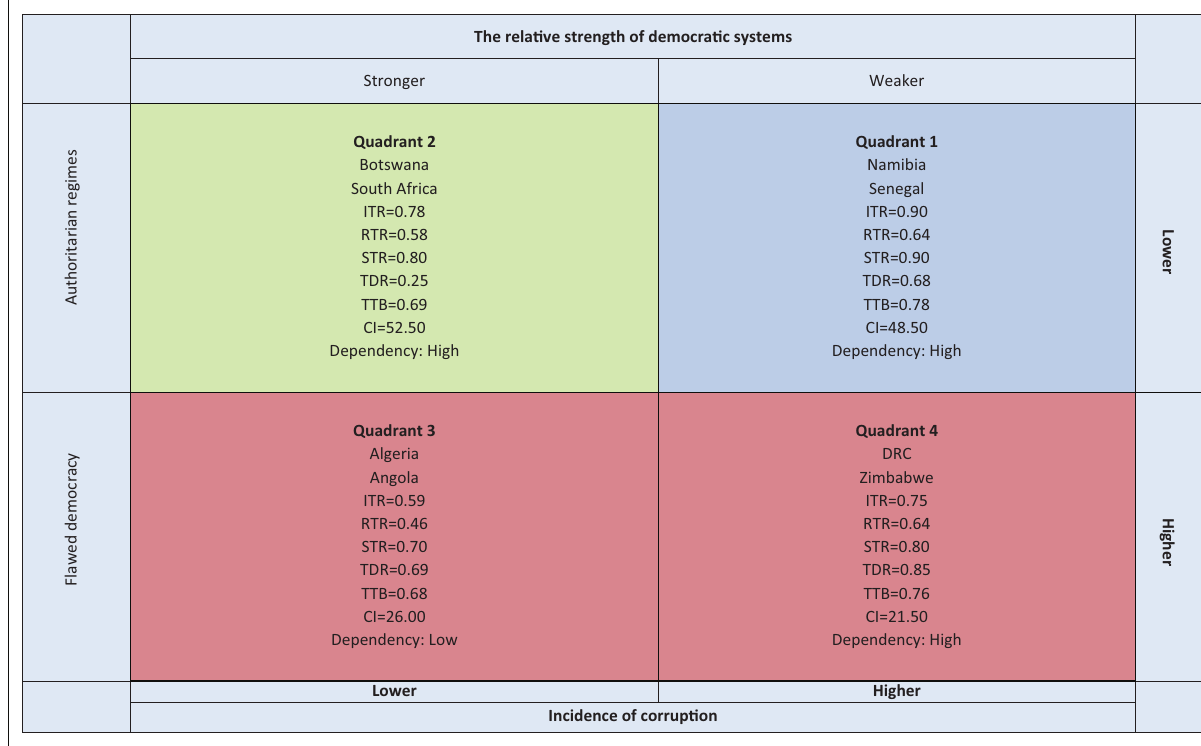
FIGURE 3: Tax burden, political system, level of corruption and dependence on